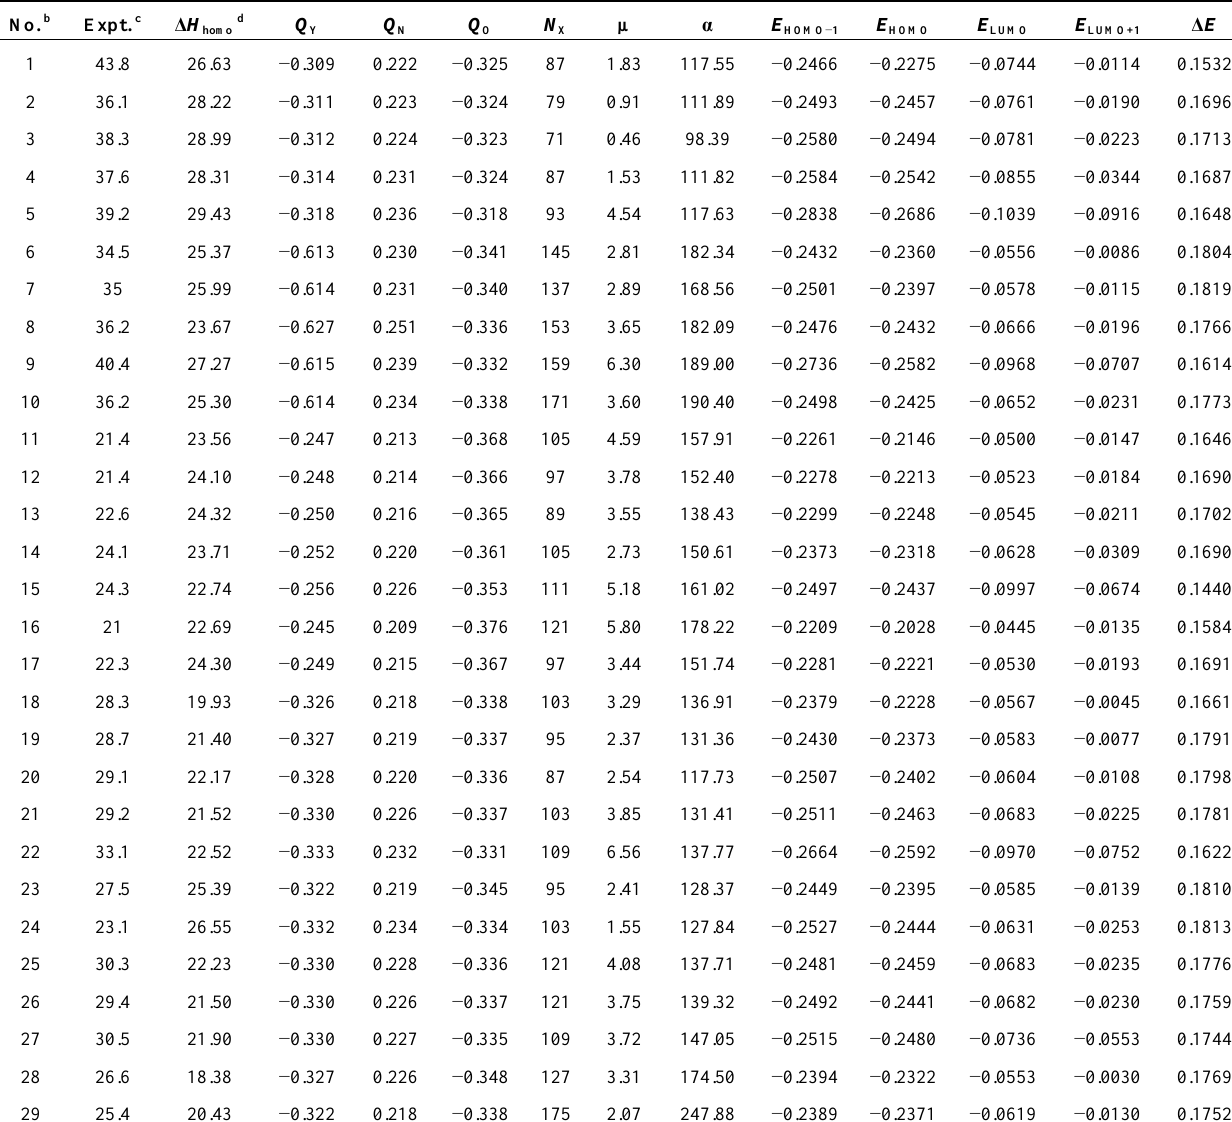
Table 2. Theoretical calculation of the Y-NO (Y = C, N, O, S) bond homolysis BDE (in the gas phase) and molecular descriptors a